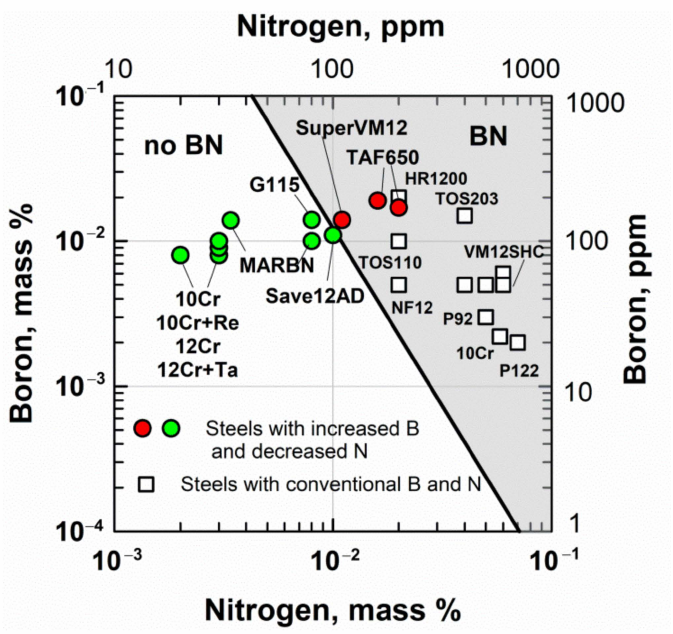
Figure 5. Composition diagram of boron and nitrogen at a normalizing temperature of 1050–1150 ◦ C. Reprinted with permission from Ref. [7]. Copyright 2017 Elsevier. Data are from Table